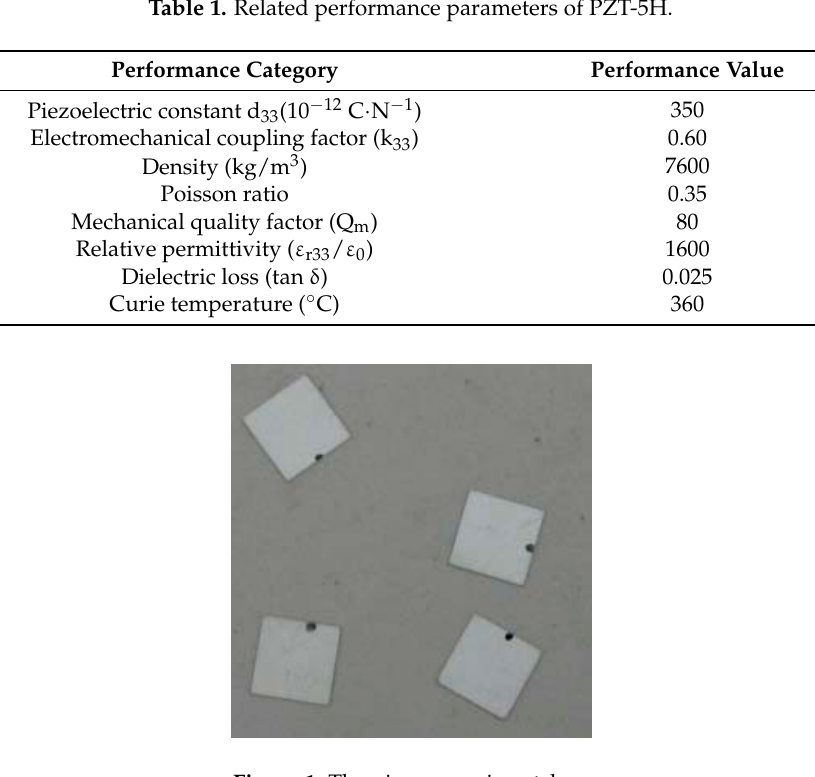
Figure 1. The piezoceramic patches.